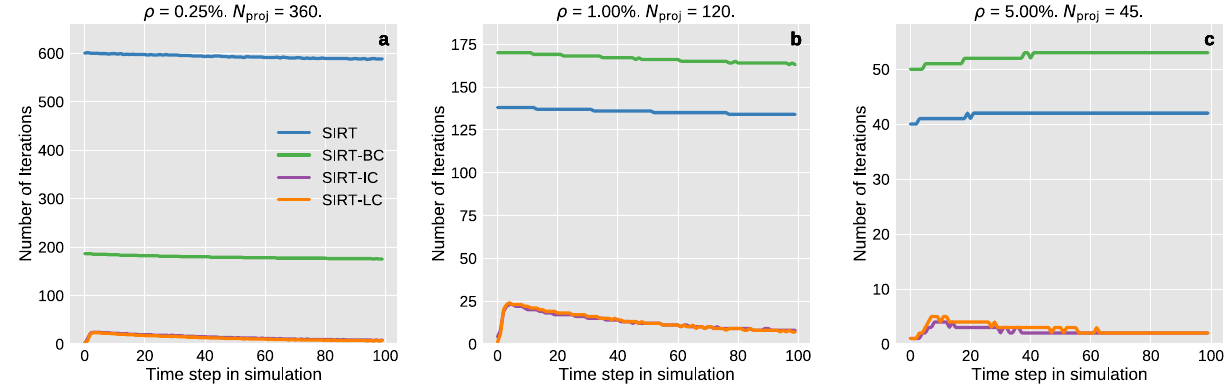
Figure 5. The number of iterations required in each time step before the NCP stopping criteria is met for the three different data cases. SIRT-IC and SIRT-LC nearly coincides in all